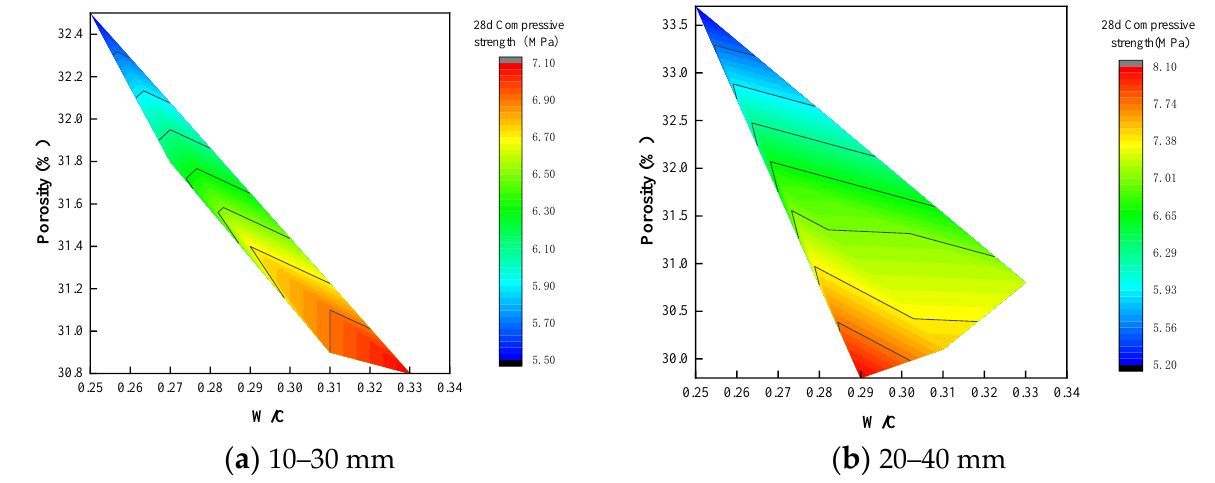
Figure 10. Effect of water – cement ratio and porosity on compressive strength. The development of the compressive strength of the concrete is shown in Figure 11. As shown in Figure 11a, the compressive strength of the planting concrete grows quickly, and the 7-day strength of the planting concrete is approximately 66 – 75% of the 28-day strength. The regression analysis revealed a linear relationship between the 28-day compressive strength and the 7-day compressive strength, which is given in Equation (4).